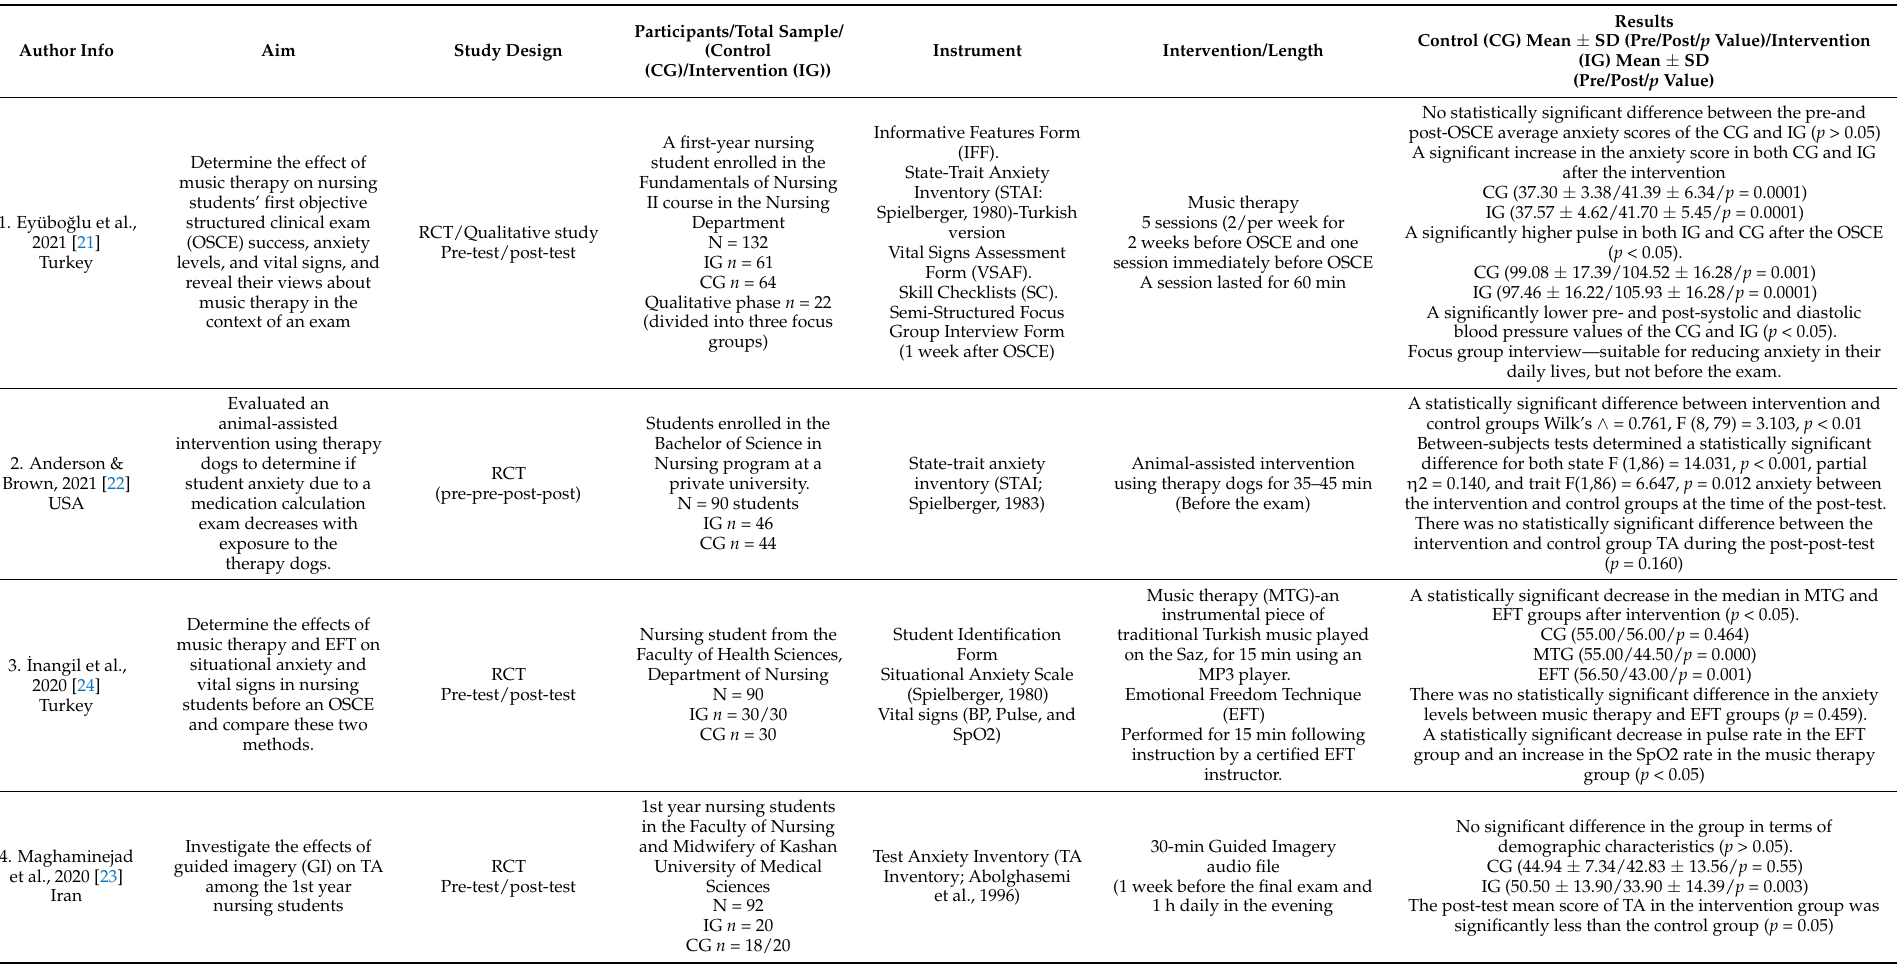
Table 3. Summary of results of extraction-test anxiety